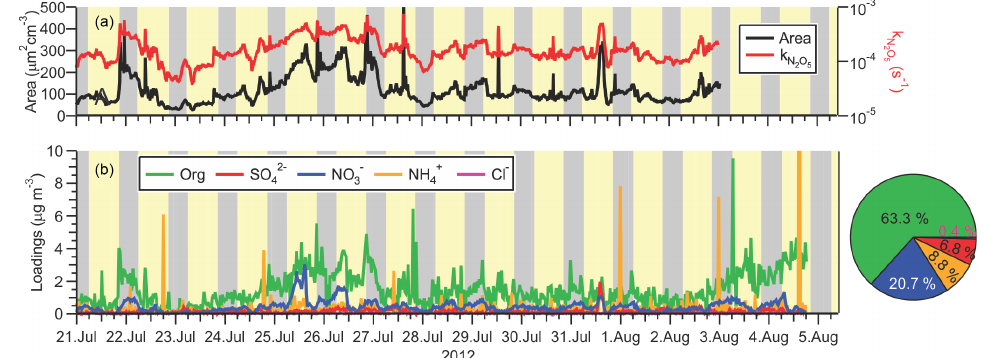
Figure 5. Time series of (a) submicron surface area density measured by the TSI 3034 scanning mobility particle sizer (left-hand side) and calculate heterogeneous N 2 O 5 uptake rate coefficient assuming γ = 0 . 025 (right-hand side), and (b) ‘ non-refractory submicron aerosol species measured by ACSM. The average total loading was 2.3µgm − 3 . The pie chart shows the average campaign